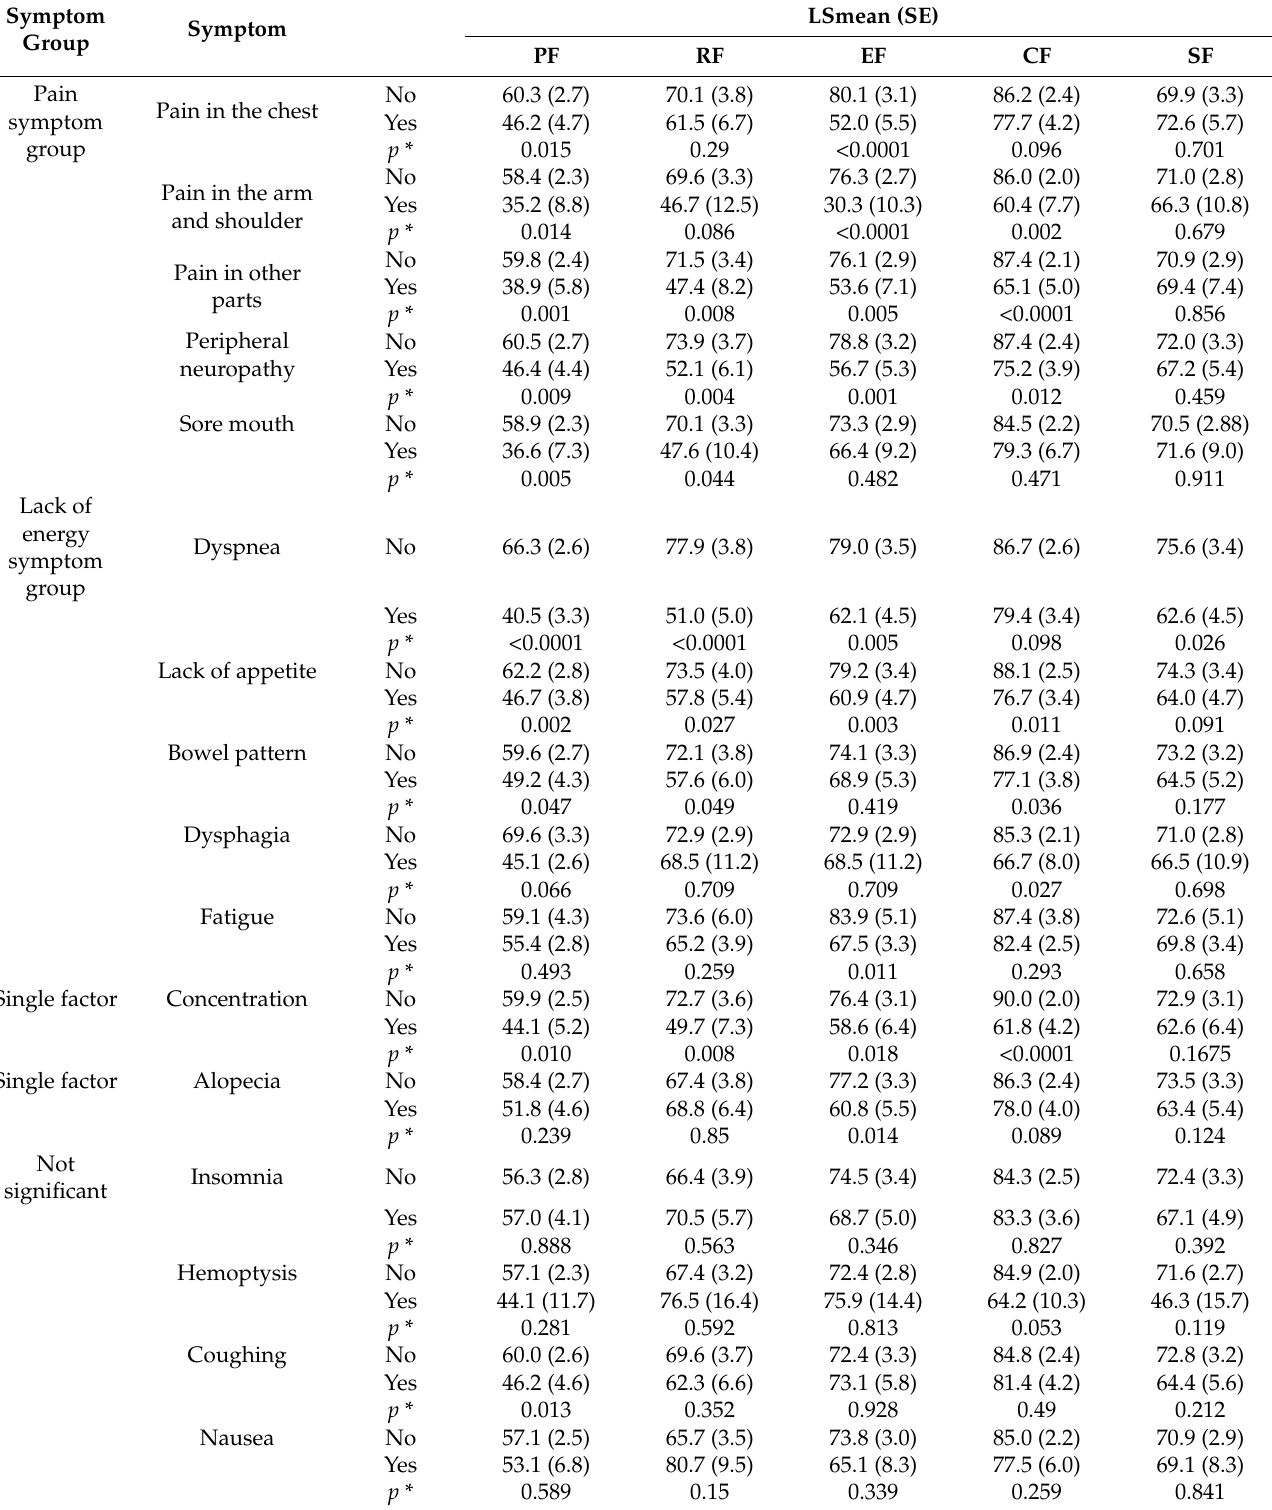
Table 3. Symptoms and their cluster affecting functioning.